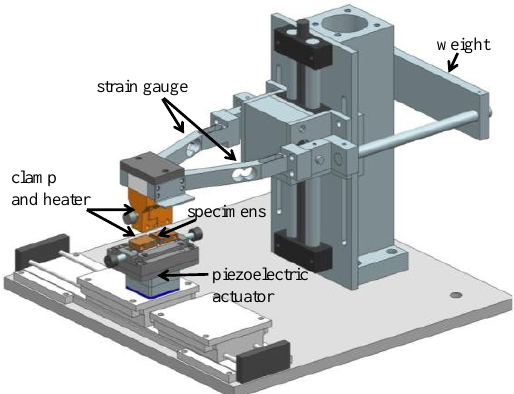
Figure 9. Apparatus for wear and fretting corrosion